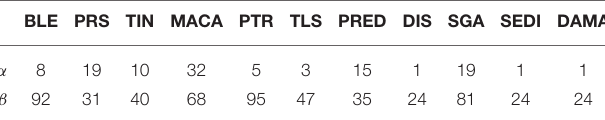
TABLE 2 | Summary of health condition diagnoses using results from a single digital observer.